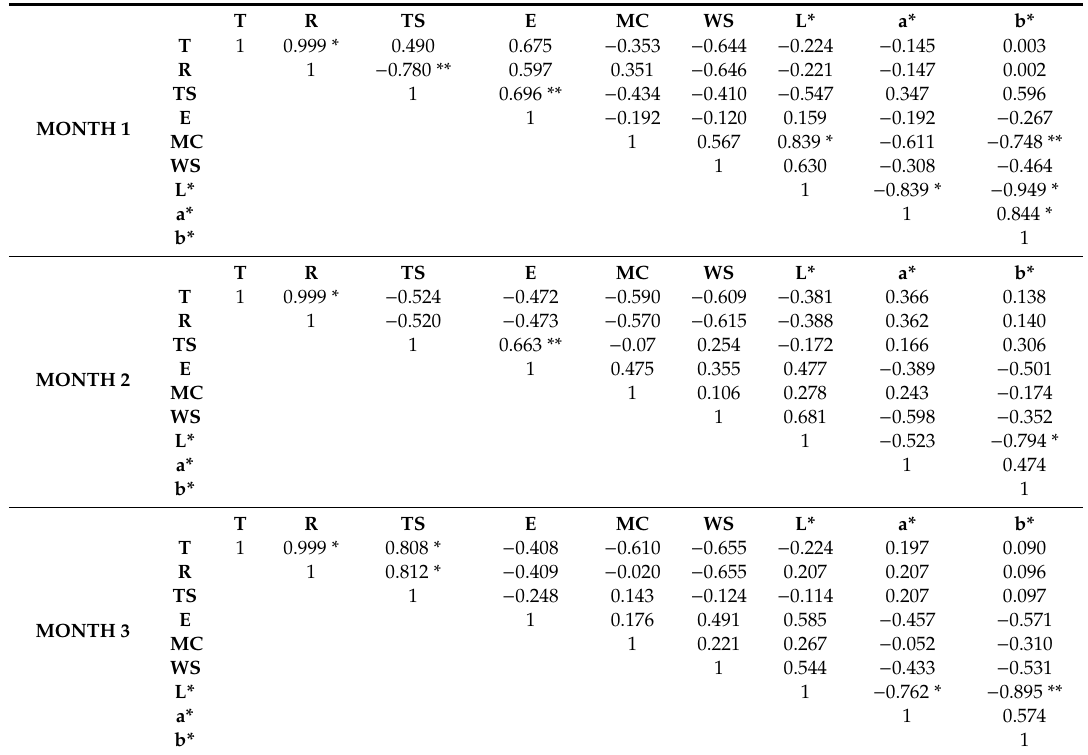
Table 2. Pearson correlation for characteristics of tested films.